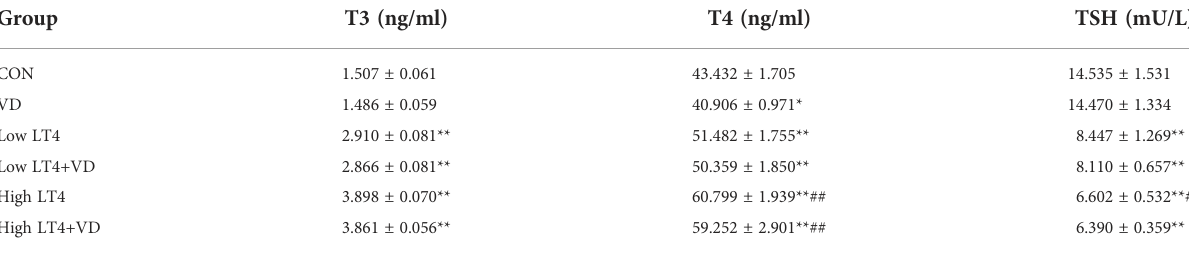
CON,mice treatedwithsaline;VD,mice treatedwithvitaminD;LowLT4,micetreatedwithLT4(30µg/100g.d);LowLT4+VD,micetreated withLT4(30µg/100g.d)andvitaminD(10 IU/g. qod); High LT4, mice treated with LT4 (60 µg/100 g. d); High LT4+VD, mice treated with LT4 (60 µg/100 g. d) and vitamin D (10 IU/g. qod). Data are shown as the means ± SEMs. Compared with the CON group, *P < 0.05, **P < 0.01. Compared with the Low LT4 group, ## P <